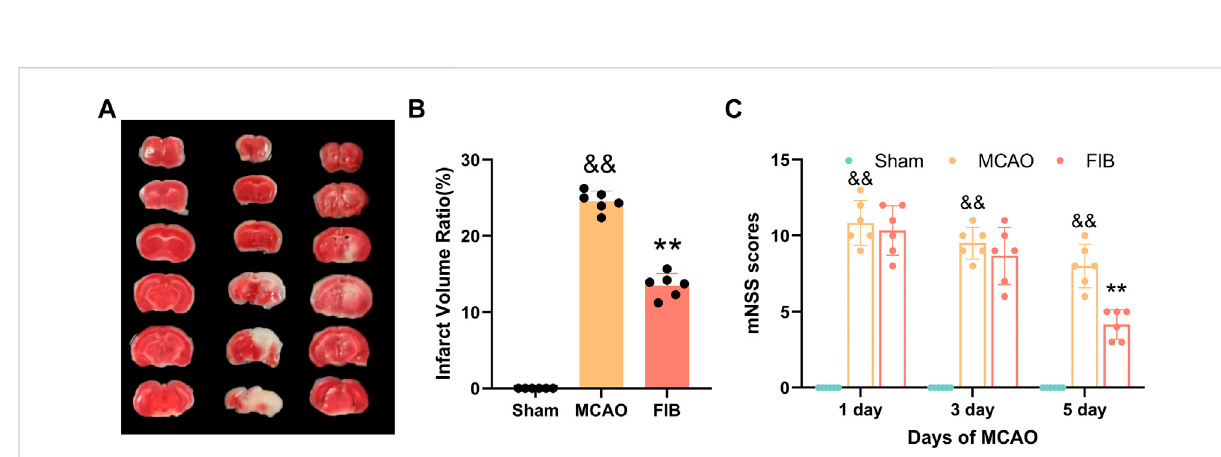
FIGURE 9 Assessment of I/R Injury Model. TCC staining of brain tissue to measure the infarct volume of brain tissue (A,B) . Neurological de fi cit score of mouse in each group after 5 days of FIB treatment (C)